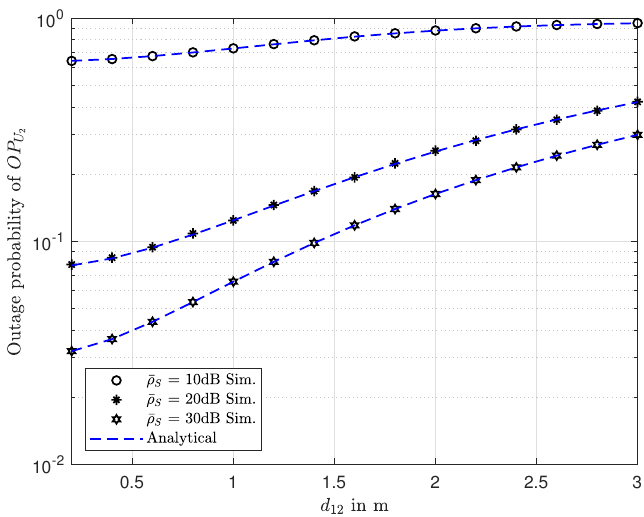
Figure 4. Outage probability of OP U